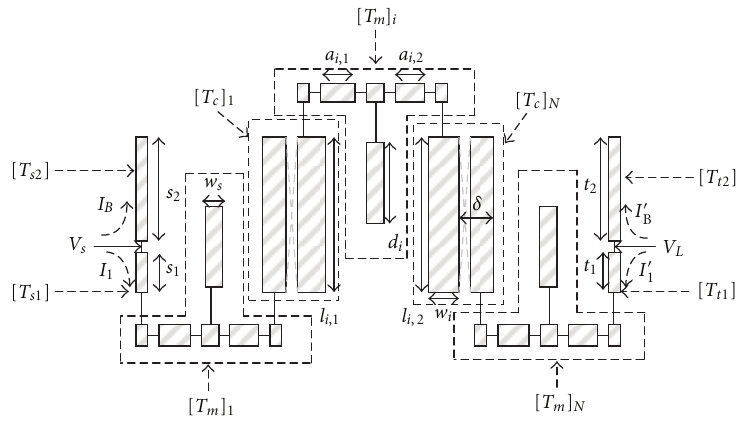
Figure 2: The equivalent circuit of hairpin filter shown in Figure 1.